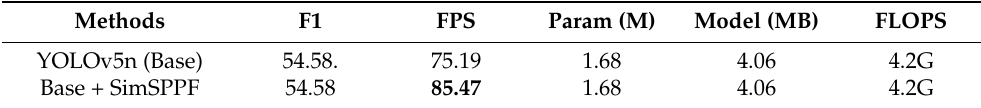
Table 4. Performance comparison of with and without the SimSPPF